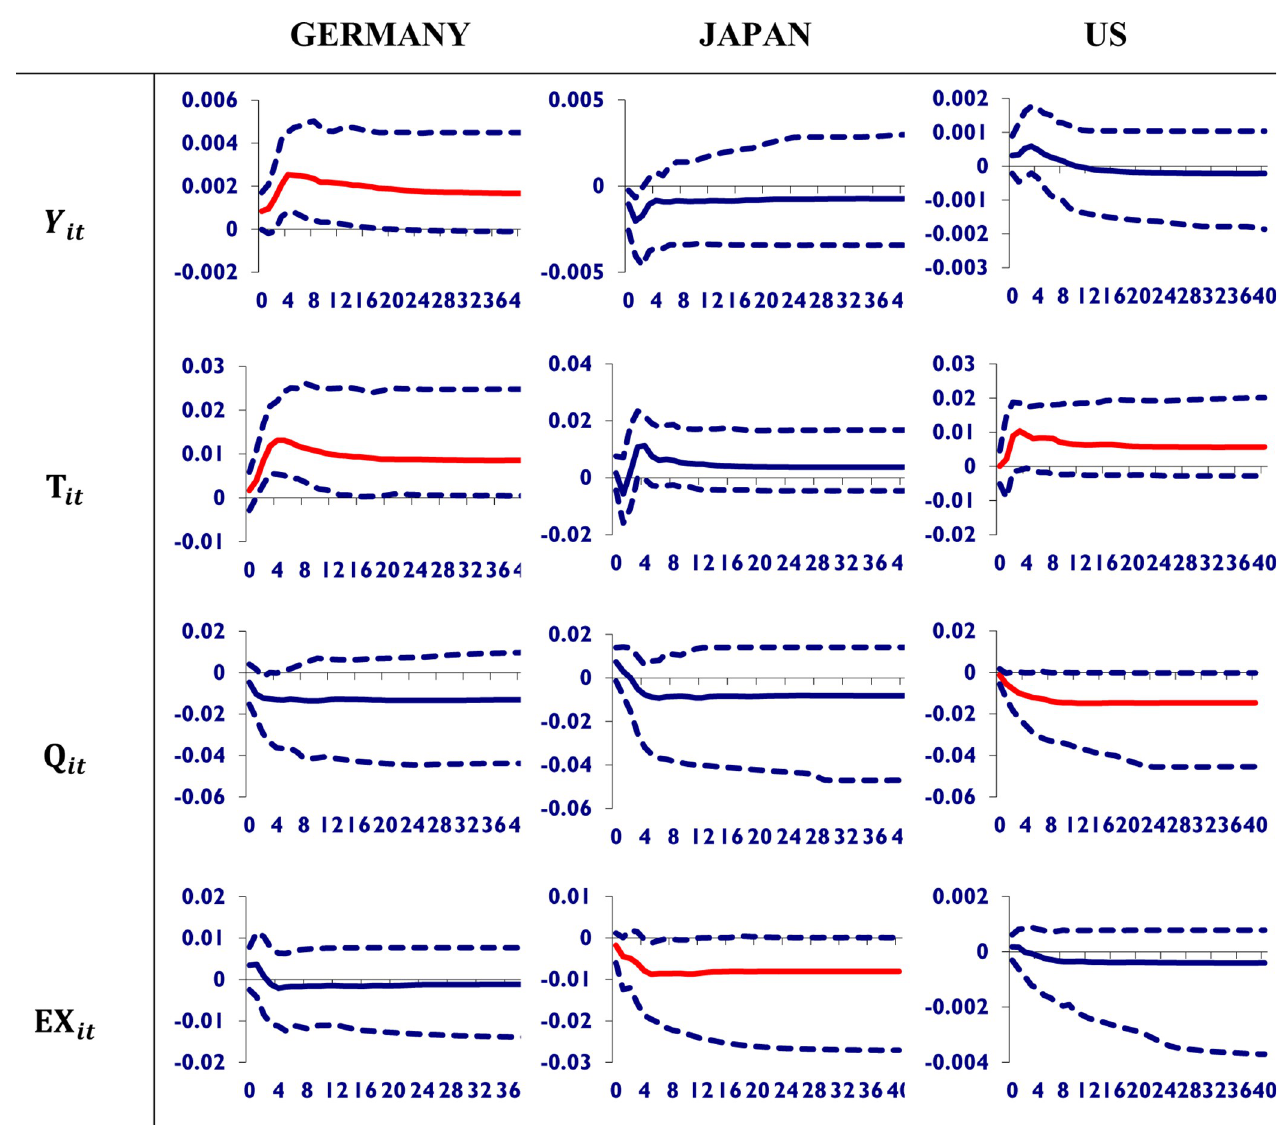
Fig 5. Shocks to Chinese real exchange rate and its impact on its trading partners economies. A shock to the Chinese exchange rate is good for Germany as it improves its GDP and trade volume, but bad for the US as it worsens its equity prices. However, Japan’s currency will be stronger in terms of appreciation due to the shock in the Chinese exchange